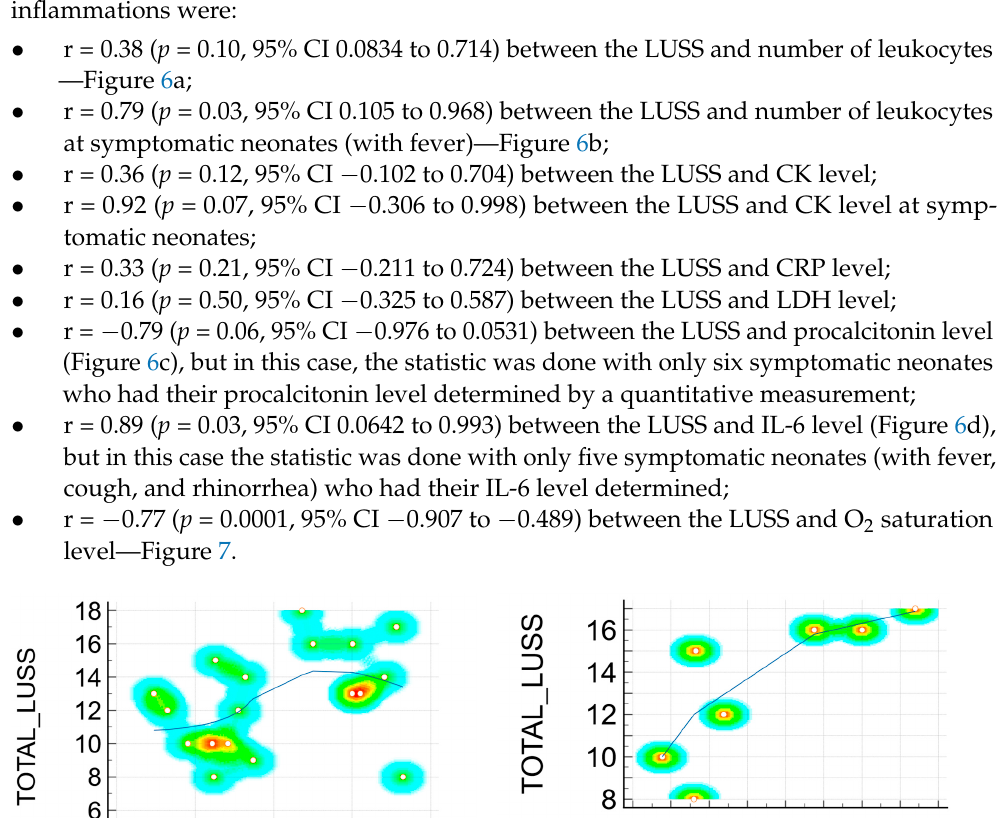
Figure 5. The relationship between symptoms (cough) and LUSS; 1 means present/affirmative and 0 means absence/negative ( a ) the frequencies chart of the Chi-squared test with a graph with a 100% stacked column; ( b ) Box-and-whisker of data comparison between LUSS at neonates with cough and LUSS at neonates without.